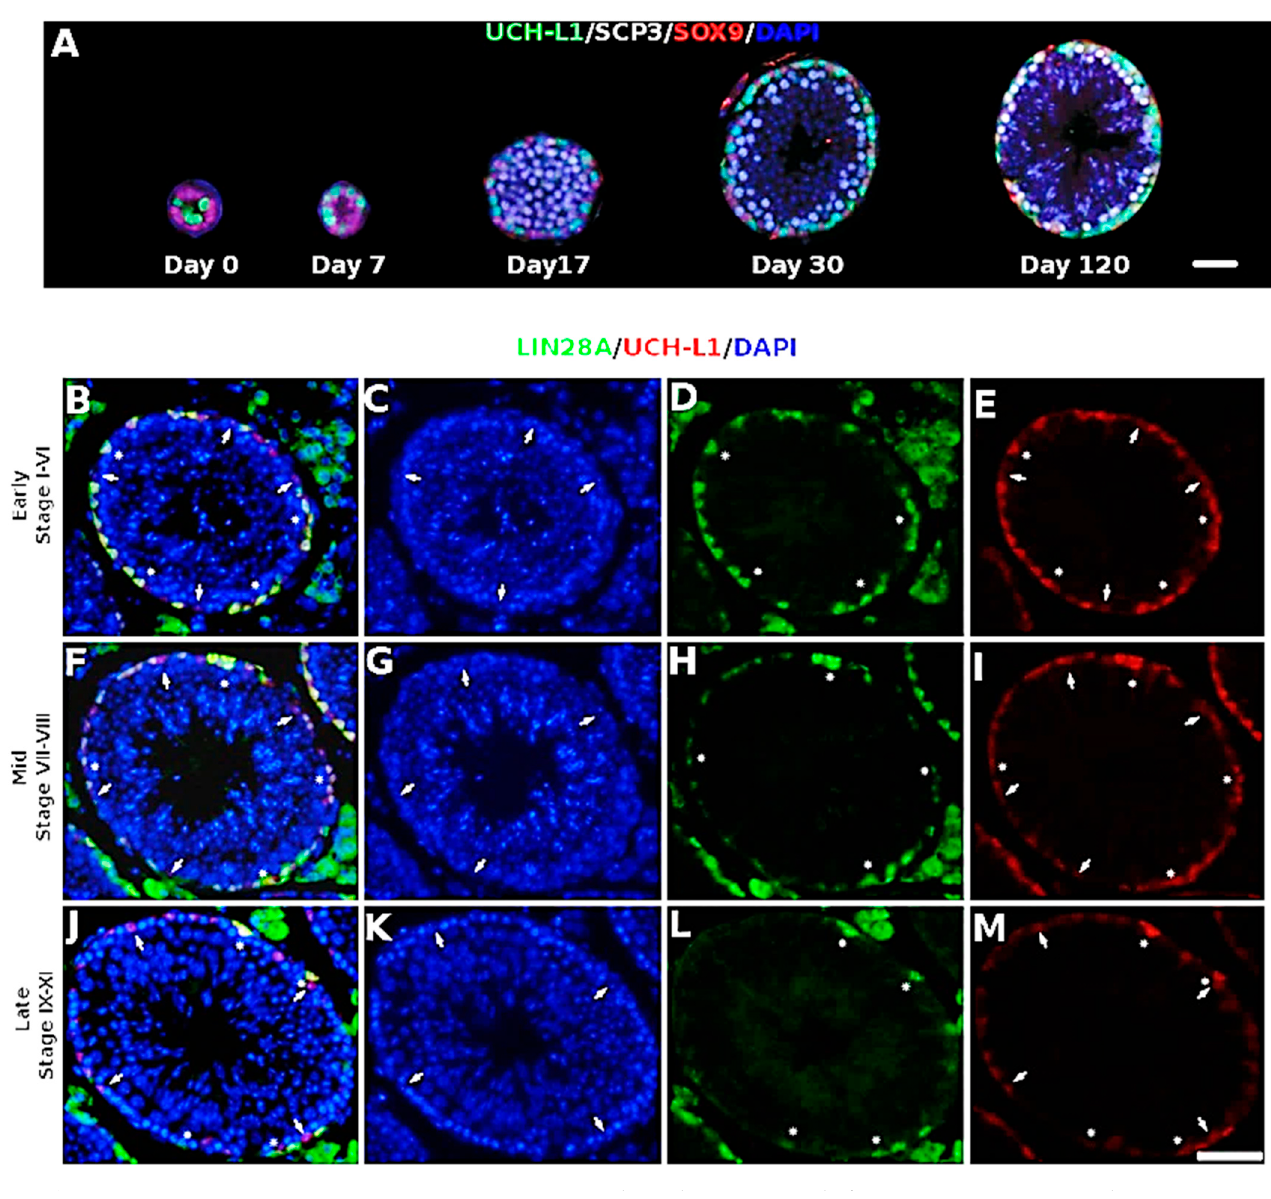
Figure 1. UCH-L1 expression in mouse testis. ( A ) Immunohistochemistry panel of UCH-L1, SOX9, SCP3 and DAPI at 0, 7, 17, 30 and 120 days old. Scale bar = 50 µm. ( B – M ) Immunohistochemistry panel of UCH-L1, LIN28A and DAPI. Arrows indicate Sertoli cells, determined by nuclear morphology, and stars indicate LIN28A positive cells. Scale bars = 50 µm.